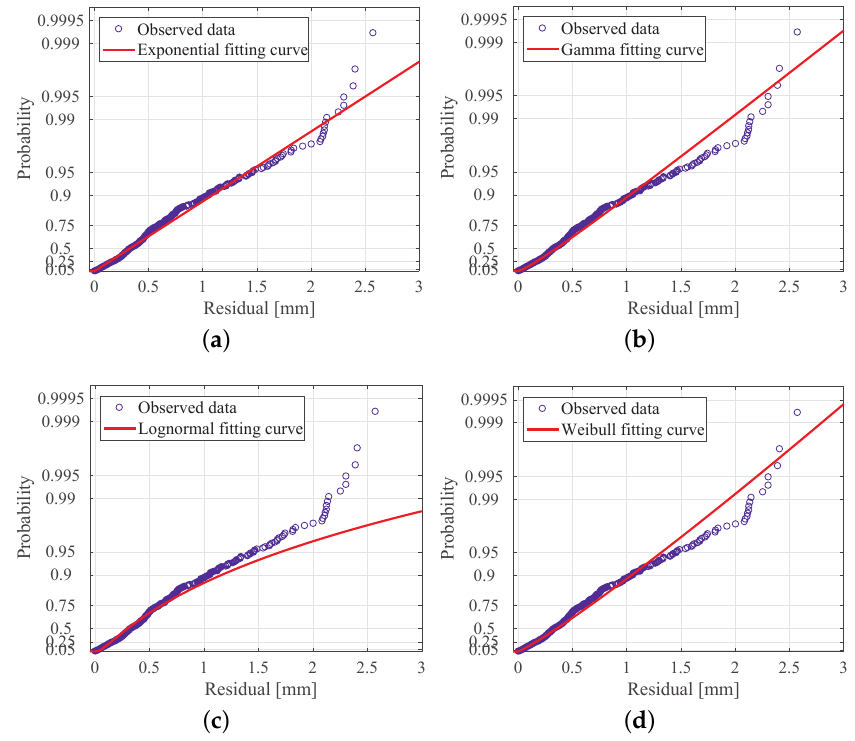
Figure 11. Univariate CDF fitting curves of | ε | 9 − 4 : ( a ) Exponential distribution function, ( b ) Gamma distribution function, ( c ) Lognormal distribution function, ( d ) Weibull distribution function.